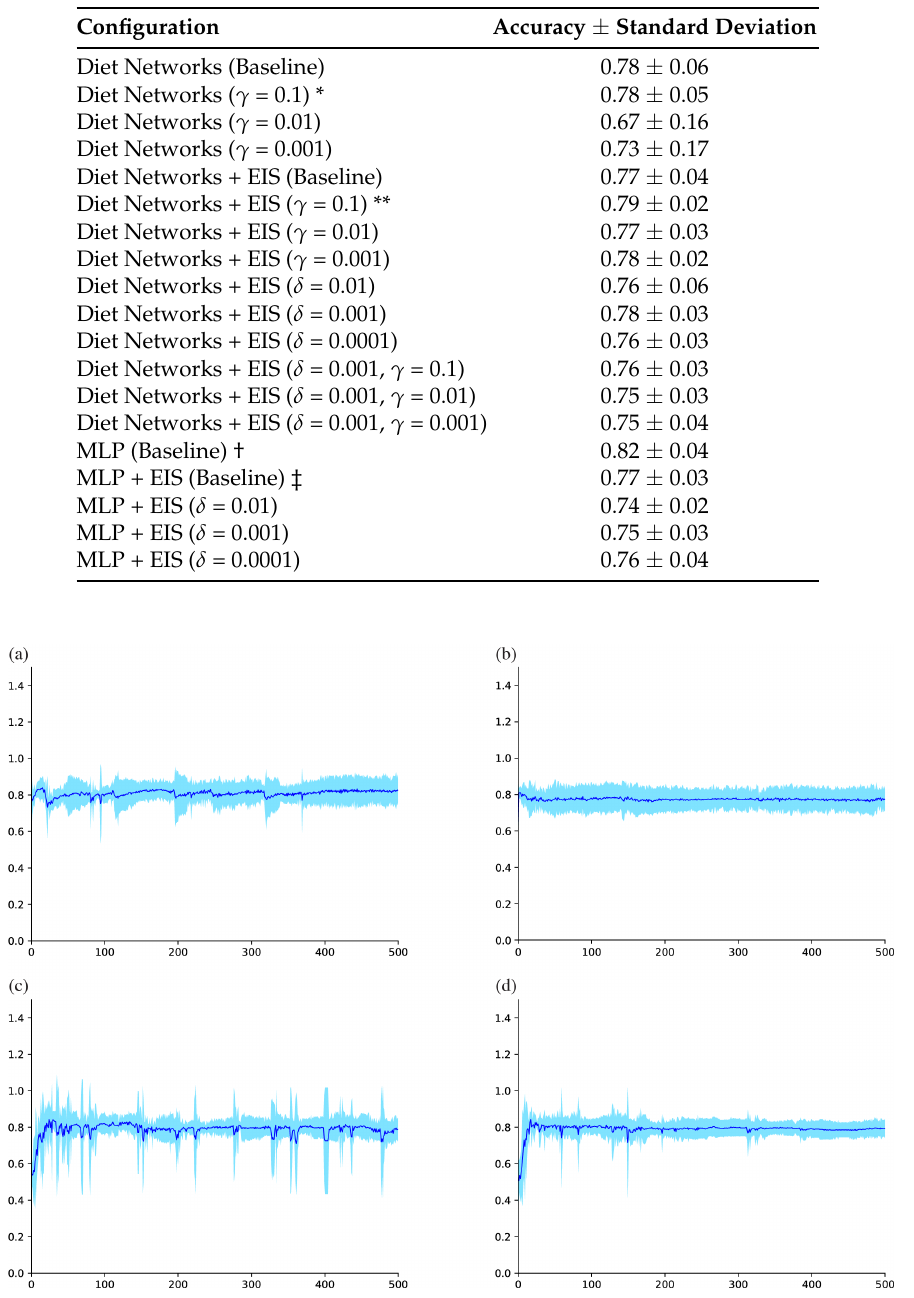
Table 2. Classification accuracy on the validation dataset. *, **, †, ‡ indicate the best configurations for each network architecture.